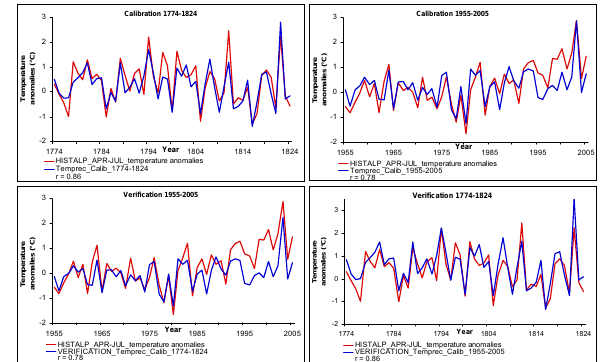
Fig. 3. Calibration and verification of homogenised Swiss Grape Harvest series with HISTALP 50-yr sub periods; 1774–1824 and 1955–2005. The best verification match was found in the 1774–1824 sub-period where HISTALP spring- summer (AMJJ) mean temperatures significantly correlated with Pearson r = 0.86 (p=0.01) . (Fig. 3). The Standard Error of Estimate (SEE) amounts to 0.5° C